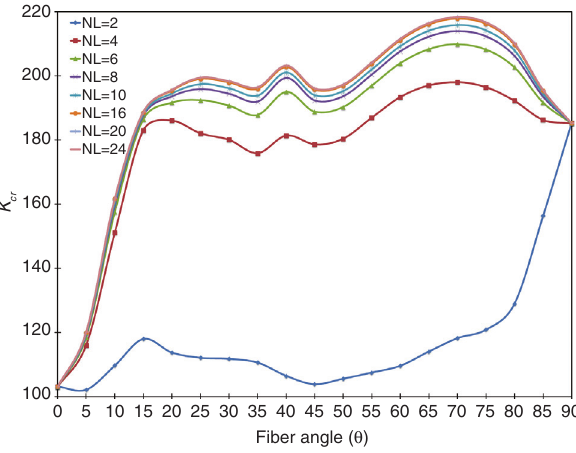
Figure 18 Critical buckling load parameter for clamped antisym- metric cylindrical skew panel (Ø = 30 ° , α = 45 °